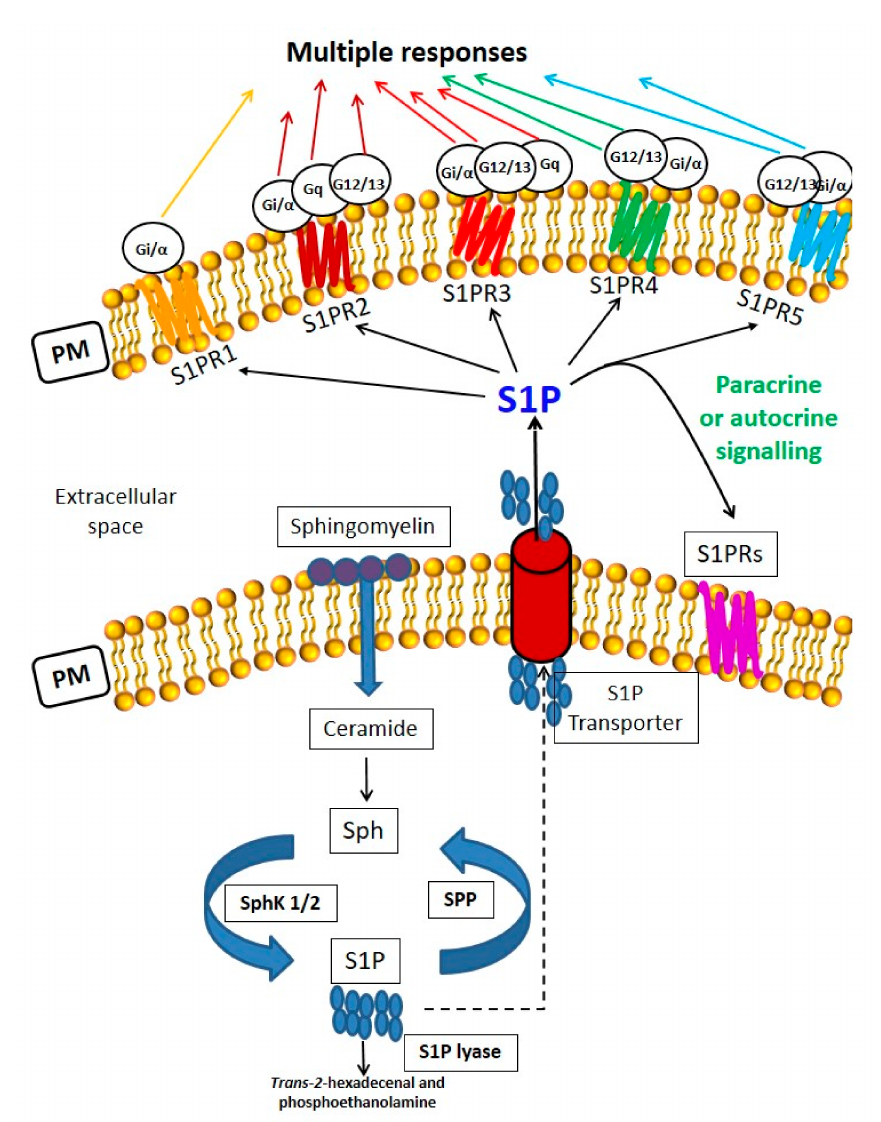
Figure 1. Sphingosine 1-phosphate-mediated signaling and sphingolipid metabolism. S1P plays a role as an intracellular mediator as well as a ligand of specific heterotrimeric GTP binding protein-coupled receptors, S1PRs, which determine multiple responses.S1P transport outside the cells is mediated by specific S1P transporters belonging to the Major Facilitator Superfamily, such as Spinster 2 (Spns 2) and Mfsd2b. Sphingolipid metabolism . Sphingomyelin is the more concentrated SL in the plasma membrane (PM) of mammalian cells. It can be hydrolysed by sphingomyelinases generating phosphocholine and ceramide [17,21]. The de novo synthesis (not shown) of SLs initiates from serine and palmitate condensation catalysed by serine palmitoyltransferase. The product, 3-keto-dihydrosphingosine, is first reduced and acylated to dihydroceramide, and then reduced to ceramide. De novo ceramide synthesis occurs in the endoplasmic reticulum Ceramide can also be phosphorylated to ceramide 1-phosphate (C1P) and substrate of ceramidase, producing sphingosine (Sph). Subsequent phosphorylation of Sph by two SphK isoforms (SphK1 / 2) generates the bioactive lipid S1P. Sphingosine-1-phosphate phosphatase (SPP) and lipid phosphate phosphatases cause S1P dephosphorylation to Sph, whereas S1P lyase degrades it to hexadecenal and ethanolamine phosphate. Notably, the interplay and the ratio between S1P and its precursors, in particular, ceramide and Sph, is a crucial determinant of cellular fate. Ceramide and Sph can regulate cell growth arrest, senescence and death, whereas S1P and C1P control cell proliferation and